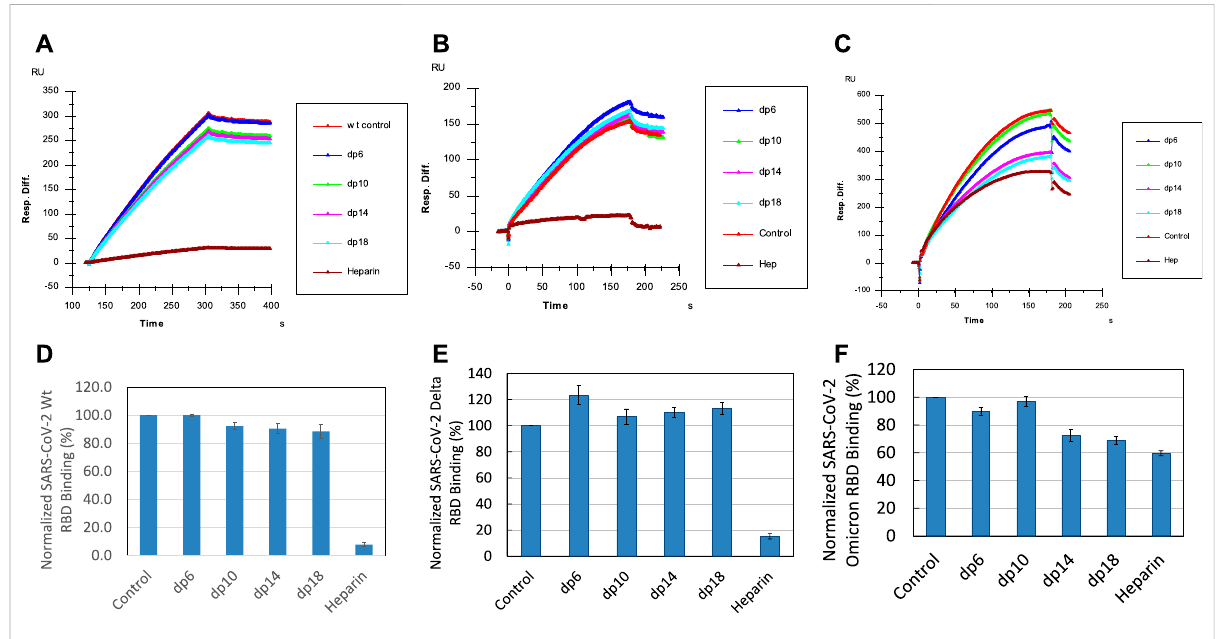
FIGURE 5 Sensorgrams and bar graphs (based on triplicate experiments with standard deviation) of normalized SGP-RBD binding to immobilized surface heparin; SGP-RBD was mixed withheparinoligosaccharides ofdifferentdegrees ofpolymerization (dp)insolution prior toinjectionindirect binding competition with the surface heparin (A) WT; (B) Delta; (C) Omicron; (D) WT; (E) Delta; (F) Omicron.